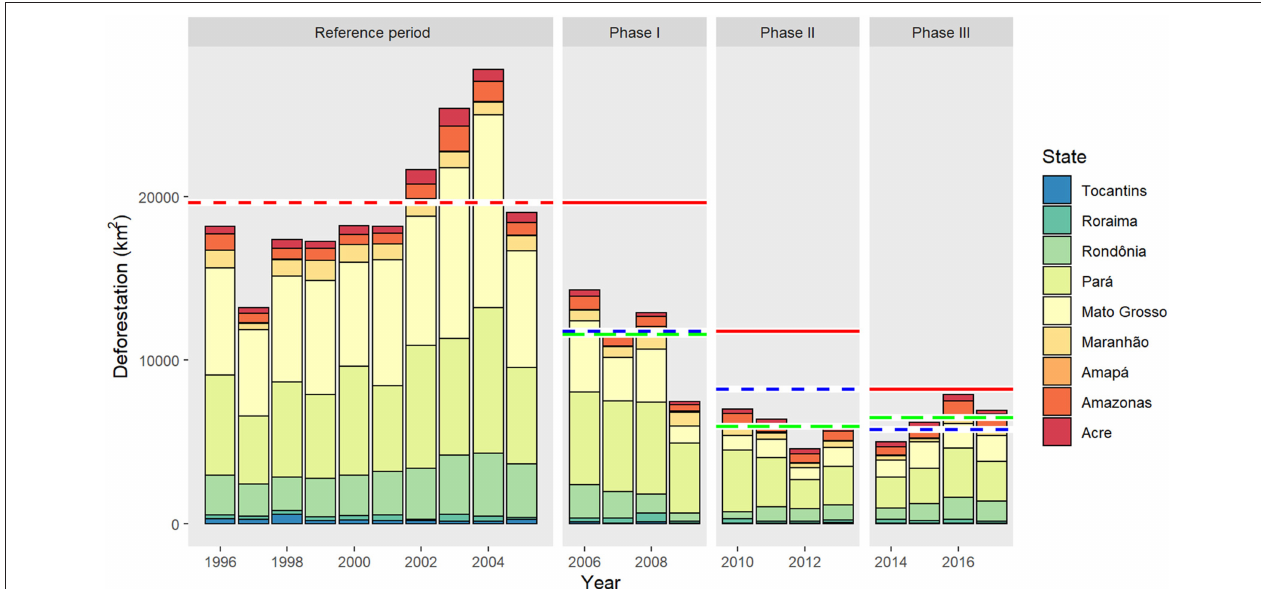
FIGURE 1 | Brazil’s original three-phase deforestation baseline set by the National Climate Change Plan (solid-red lines). Dashed-red line is the baseline reference period based on the average 1996–2005 deforestation. Dashed-blue lines represent deforestation reduction targets. Dashed-green lines are observed deforestation